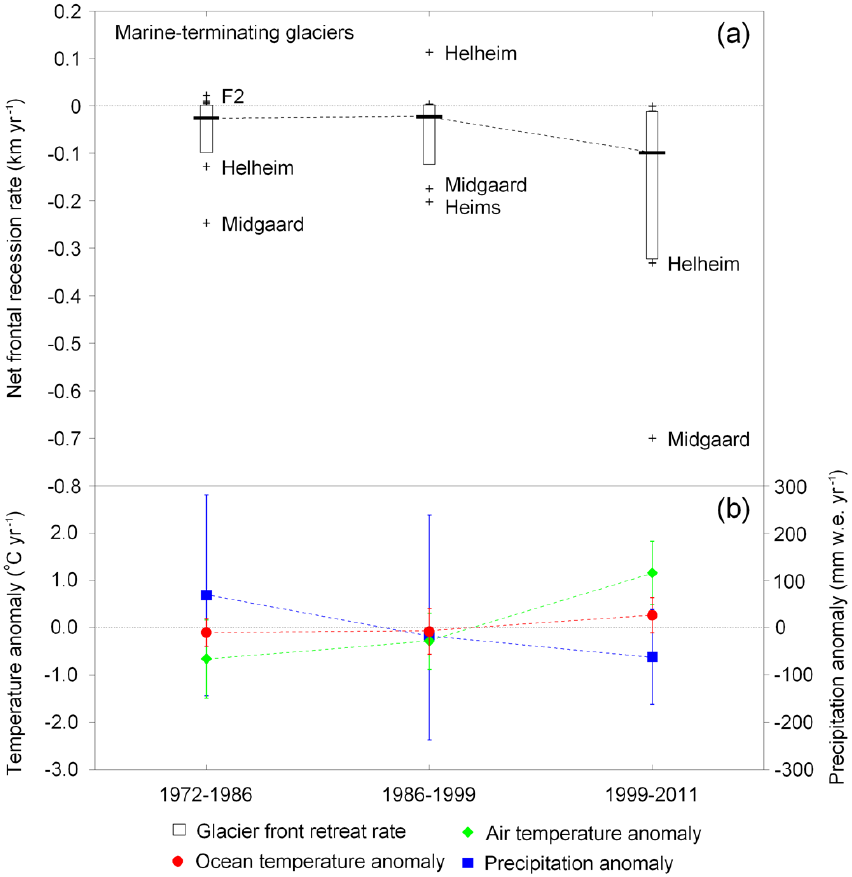
Fig. 5. (a) Box plots of frontal-position change for the sample 21 marine-terminating glaciers in the Ammassalik region with measurements in each of the 1972–1986, 1986–1999, and 1999–2011 survey periods. The edges of the boxes denote 25% and 75% percentiles and the vertical line mean. Data points outside this range are considered outliers and are plotted as crosses and labeled; (b) mean annual air temperature anomaly (observed at the DMI meteorological station in Tasiilaq), mean annual ocean water temperature anomaly at 400m depth in the Irminger Sea (Johannessen et al., 2011), mean annual precipitation anomaly (uncorrected) (observed at the DMI meteorological station in Tasiilaq) and standard deviations are